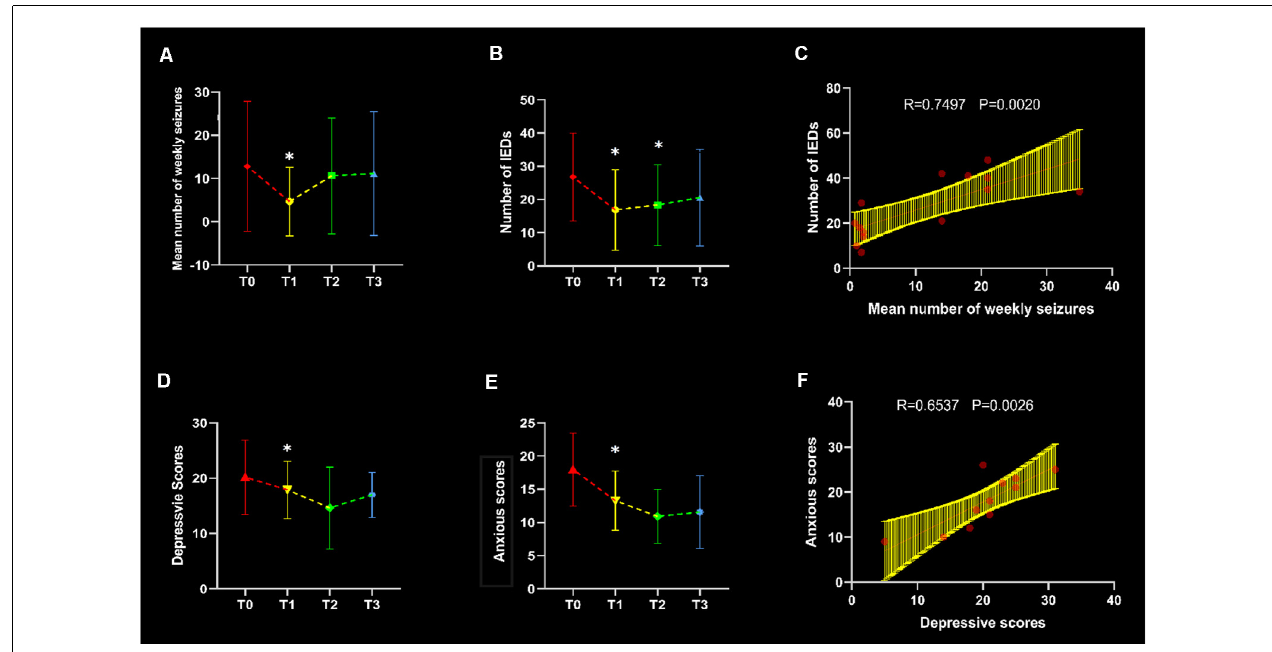
FIGURE 3 | Clinical evaluation and correlation. Line graphs were plotted in terms of the comparisons between three follow-up time points and baseline ( p < 0.05), with asterisks indicating significant changes. The mean number of weekly seizures (MNWS), interictal epileptiform discharges (IEDs), depressive scores and anxious scores in each time points were shown in panels (A,B,D) and (E) respectively. In the T0 baseline, IEDs showed an increased association with MNWS in (C) , and a positive correlation was found between depressive and anxious scores in (F)